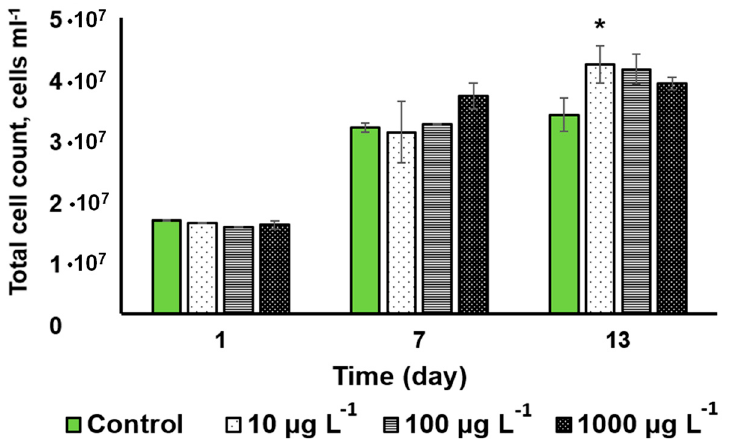
Figure 4. The changes in Desmodesmus sp. cell density in the cultures as a function of the added CuO-NP concentration. (Values significantly differing from the control are marked with an asterisk, *). Judging from the cell viability and cell density, the tested microalga Desmodesmus sp. turned out to be relatively resilient to the effects of